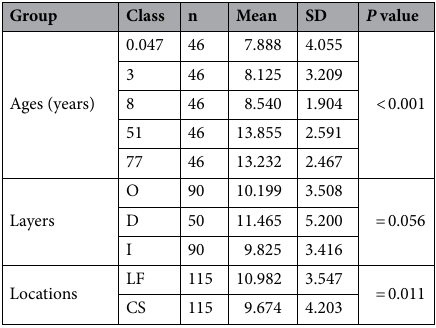
Table 3. E single-factor ANOVA.